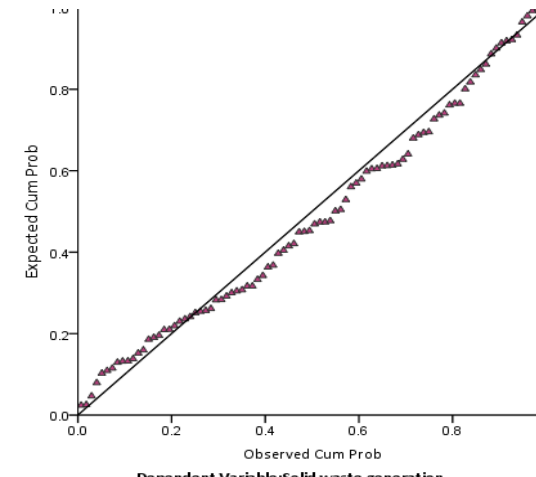
Fig. 4: Residual P-P plots for normality assumption